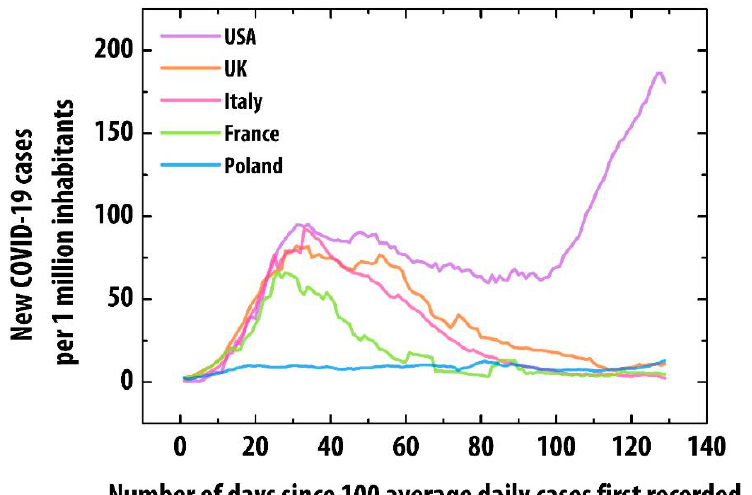
Figure 1. New COVID-19 cases per 1 million inhabitants in Poland compared with France, Italy, the United Kingdom (UK) and the United States of America (USA)—countries with reported cases of pediatric inflammatory multisystem syndrome (PIMS) [15].